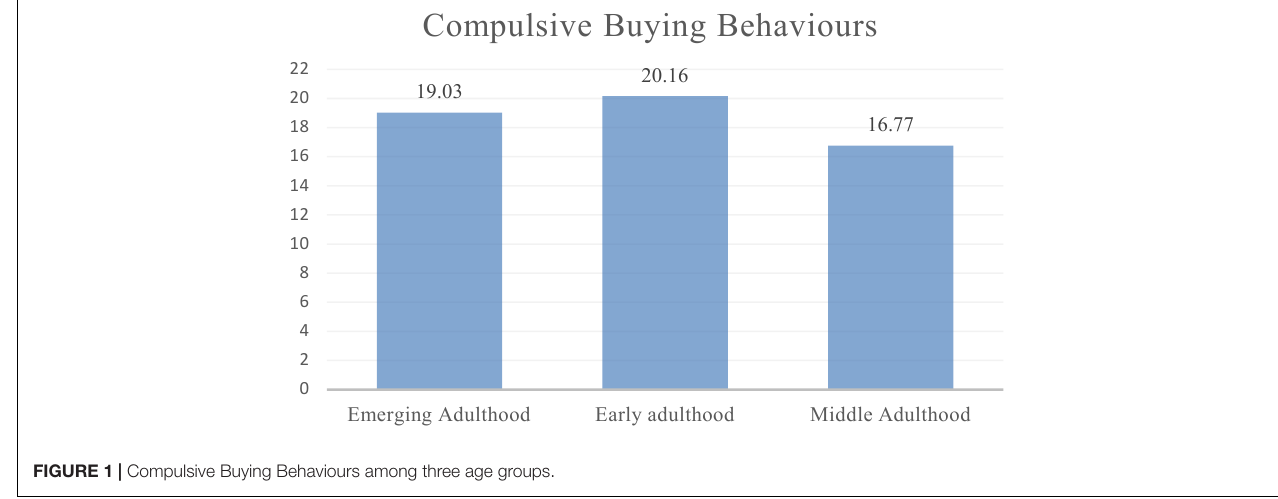
FIGURE 1 | Compulsive Buying Behaviours among three age groups.